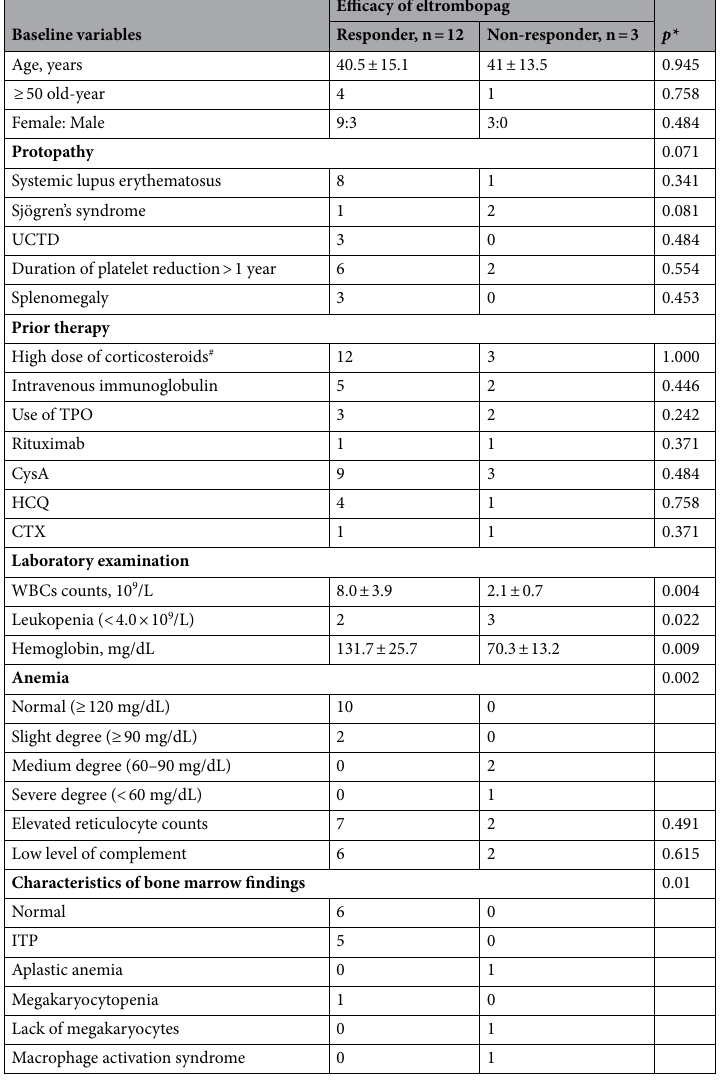
Table 3. Comparison of baseline variables between responder and non-responder of eltrombopag in patients with connective tissue disease-associated immune thrombocytopenia (CTD-ITP). Continuous variables were presented as mean ± (standard deviation). CysA cyclosporine A, CTX cyclophosphamide, HCQ hydroxychloroquine, ITP idiopathic thrombocytopenic purpura, UCTD undifferentiated connective tissue disease, WBCs white blood cells, TPO thrombopoietin. *p was shown with exact significance on one-sided or asymptotic significance on two-sided. # High dose of corticosteroids were defined as at least 1 mg/kg day; responder, complete remission plus partial